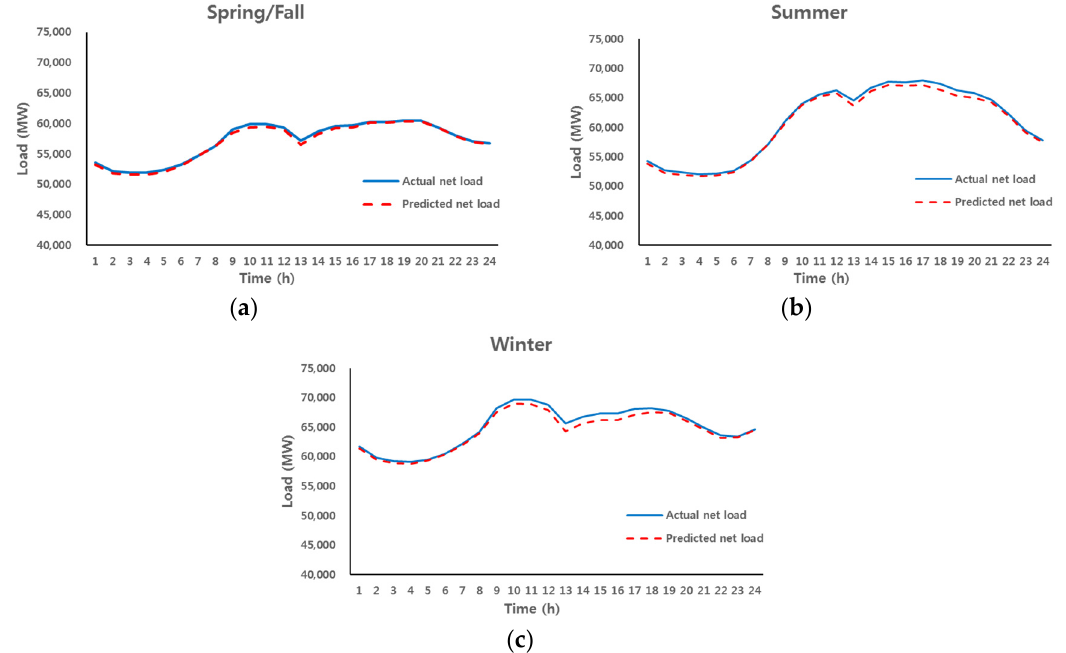
Figure 4. The comparison of the actual net load curve for 2018 and the predicted net load curve by season for 2018: ( a ) The actual net load curve vs. predicted net load curve in spring/fall; ( b ) The actual net load curve vs. predicted net load curve in summer; ( c ) The actual net load curve vs. predicted net load curve in winter. Table 6. Seasonal error rate between the actual net load and predicted net load for 2018. Season Spring/Fall Summer Winter